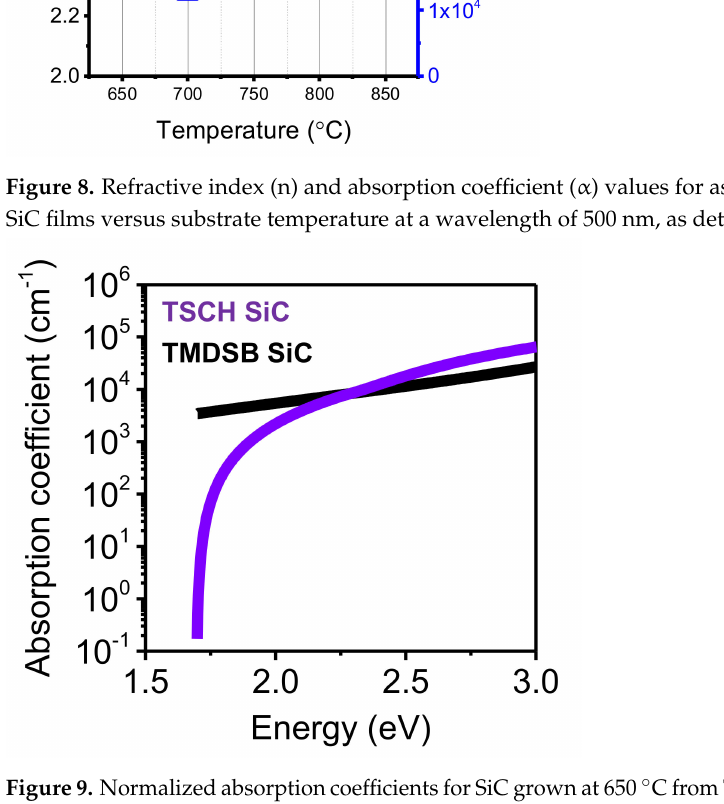
Figure 9. Normalized absorption coefficients for SiC grown at 650 ◦ C from TSCH versus SiC deposited from TMDSB at 800 ◦ C, as determined by